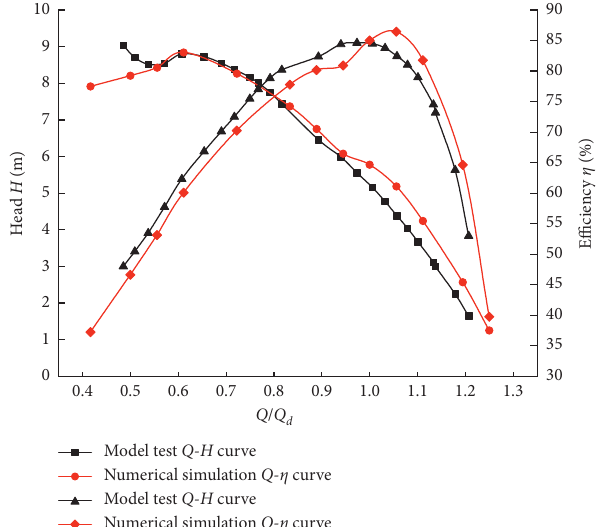
Figure 7: Performance comparison of numerical simulation and model